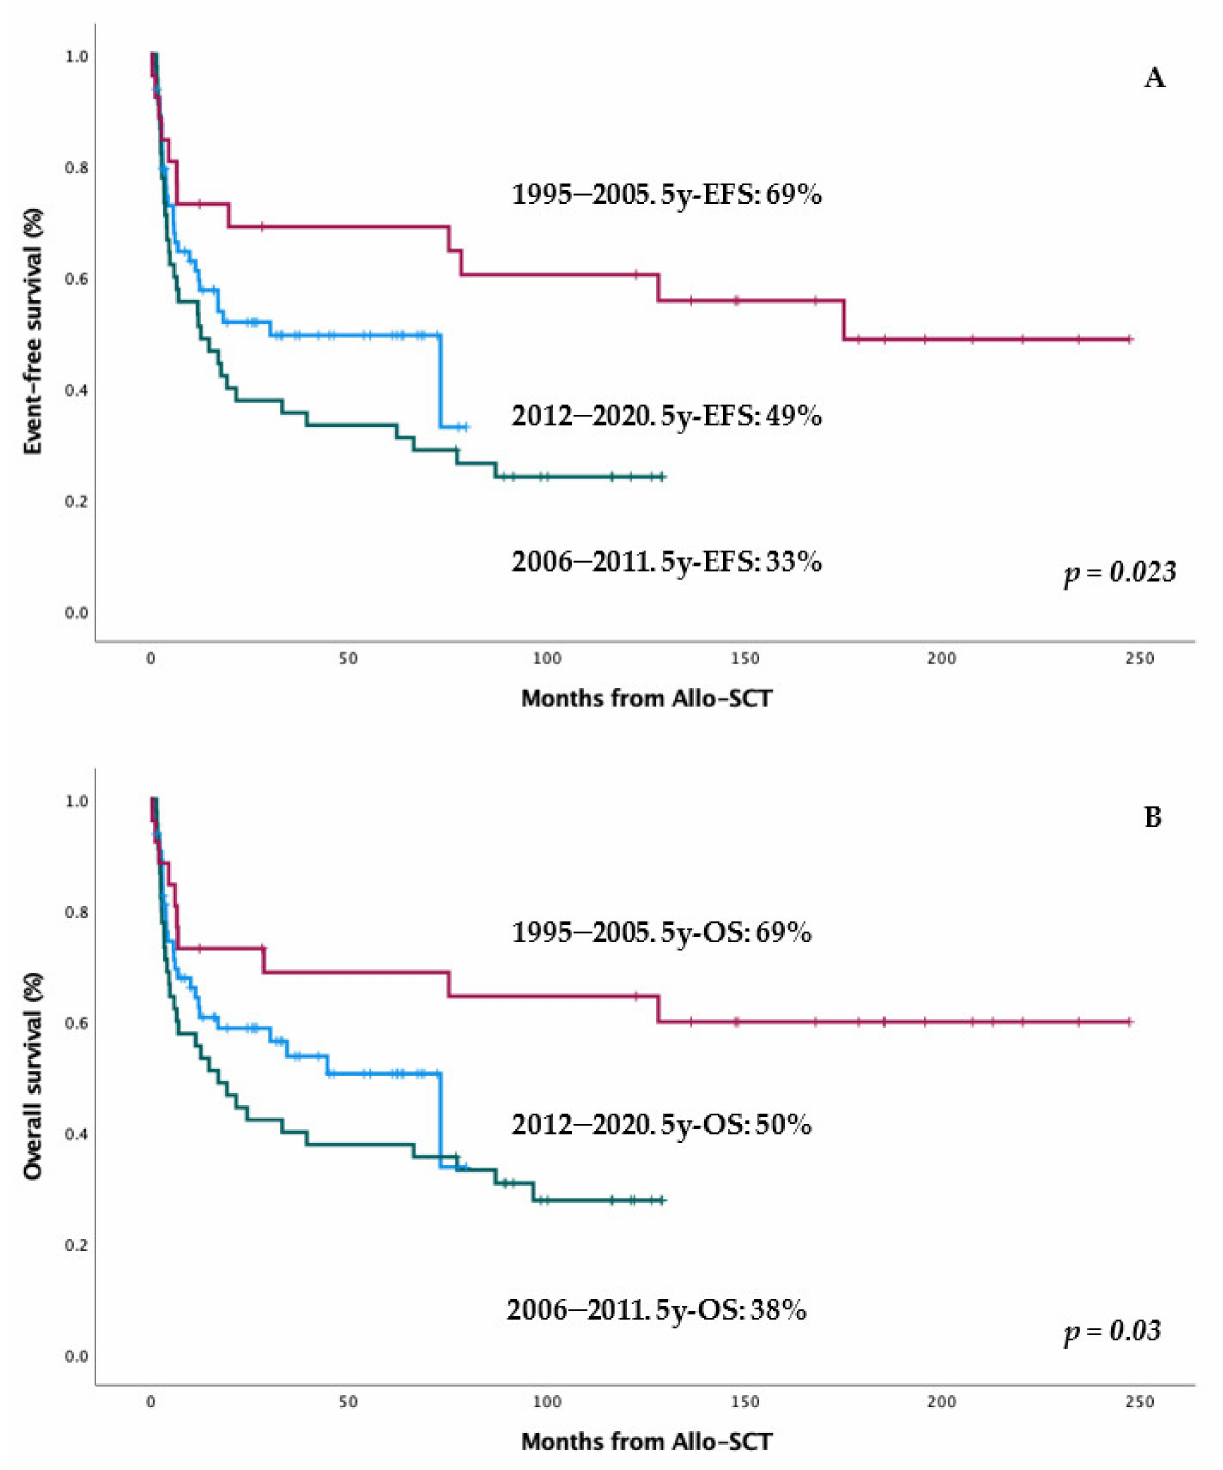
Figure 2. Impact of time-periods in EFS ( A ) and OS ( B ) after